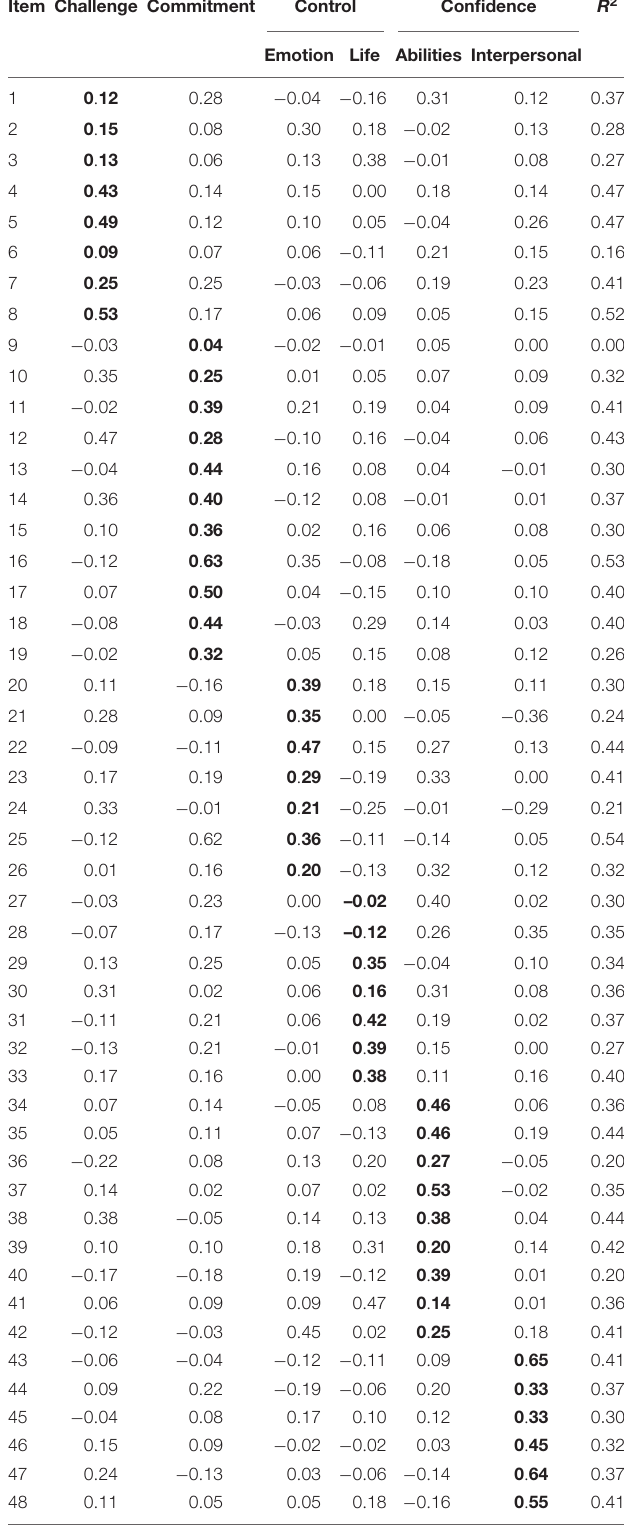
Intended factor loadings highlighted in bold. Item number does not correspond to item order of